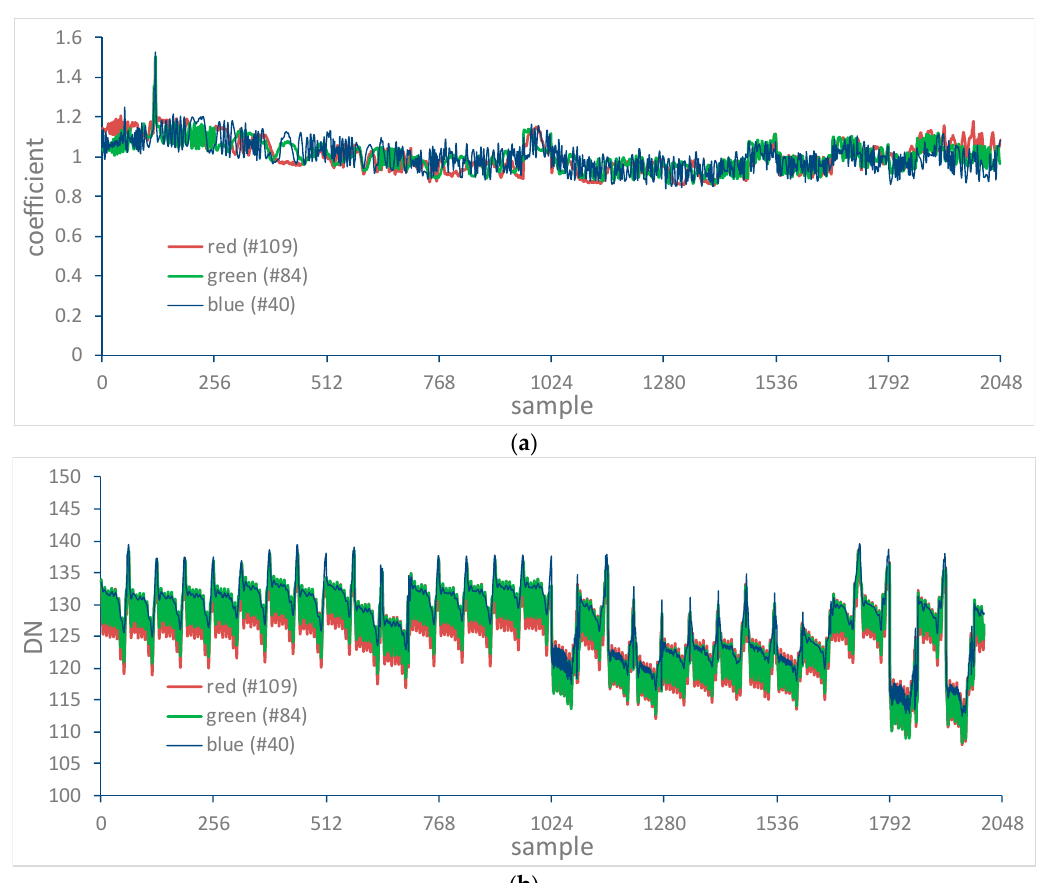
Figure 18. Relative radiometric correction coefficients for SPARK-01 satellite images at 650.4 nm, 551.5 nm, and 461.7 nm showing ( a ) gain curves (non-uniform correction coefficients) and ( b ) offset curves (dark current).